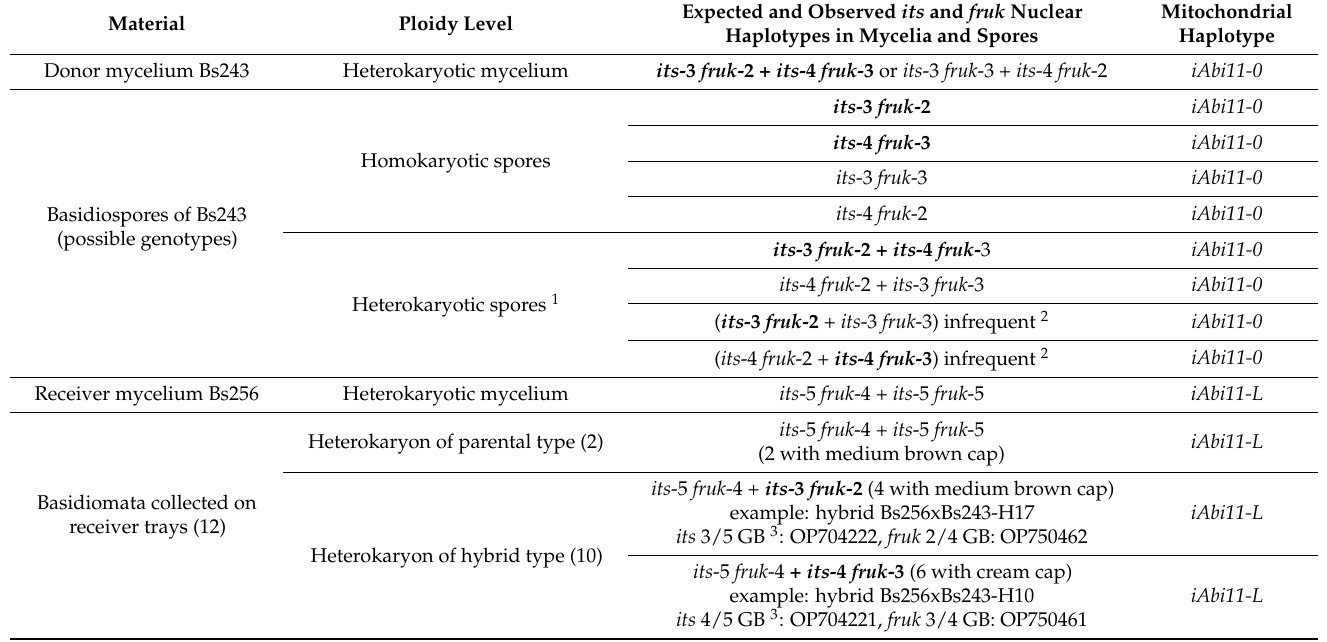
Table 4. Nuclear and mitochondrial haplotypes of parental mycelia, expected spores, and col- lected basidiomata in the outcrossing experiment between Bs256 mycelium and airborne propagules from